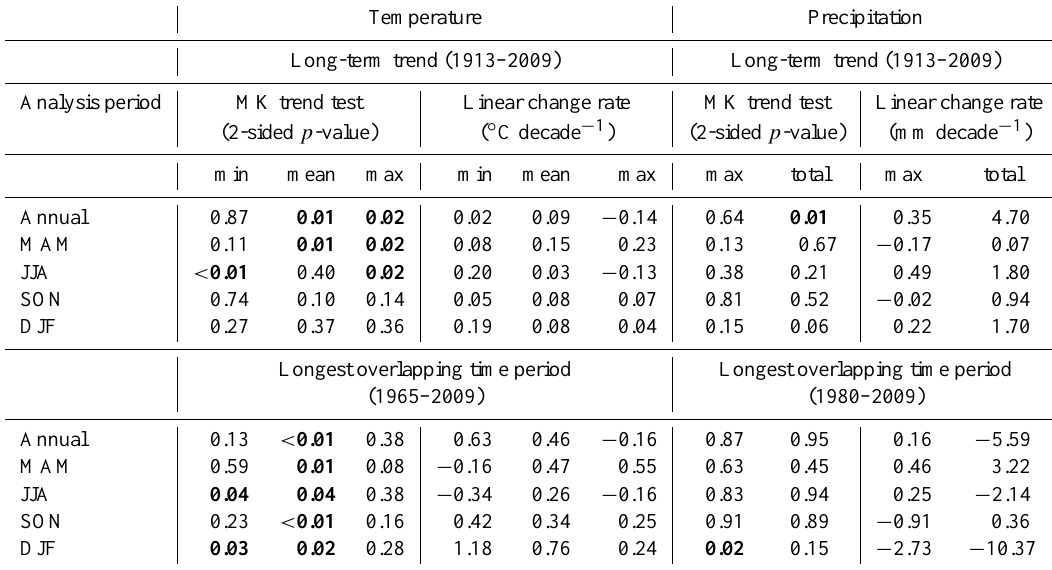
Table 4. Mann-Kendall (MK) trend test statistics on the maximum available time series data of annual and seasonal precipitation and temperature data (1913–2009) (upper table). The lower table shows MK trend statistics for time periods where both temperature (1965– 2009) and precipitation data (1980–2009) from the Abisko and Tarfala catchment were available. Trend significance of the MK trend test is indicated by the 2-sided p -value and trends significant at the 5% level are highlighted in bold. Linear change rates and the type of change (i.e., increasing (positive values), decreasing (negative values)) were estimated from the slope of a linear regression fitted to the